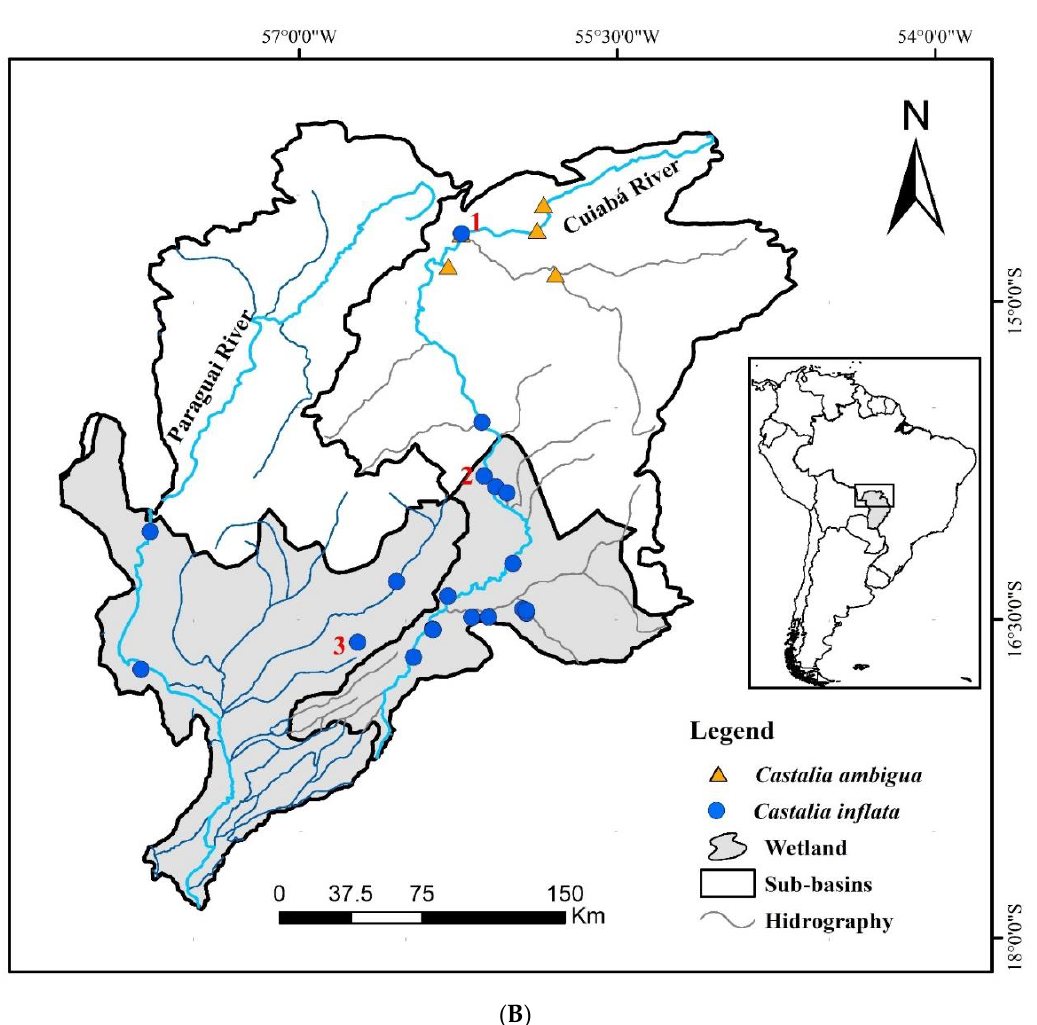
Figure 1. Locations of past and present studies of Castalia species. ( A ) . Chronology of registered occurrences of Castalia ambigua Lamarck, 1819 and Castalia inflata d’Orbigny, 1835 in South America. Orange symbols denote C. ambigua and blue denote C. inflata . The Amazon basin is to the north, and the Paraguay basin to the south. References: Bonetto 1961 [5], Bonetto 1962 [31], Bonetto 1965 [11], Mansur 1970 [7], Serrano et al. 1998 [32], Castillo 2007 [33], Wantzen et al. 2011 [34], Colle and Callil [22], Beasley 2001 [35], Vale et al. 2005 [6], Rumi et al. 2008 [12], Pimpao et al. 2008 [36], and Pimpao and Mansur 2009 [37]. ( B ). Locations of occurrence and sample sites for Castalia ambigua Lamarck, 1819 (orange triangles) and Castalia inflata d’Orbigny, 1835 (blue dots) within the upper Paraguay River basin in this study. Red numerals indicate sample sites for molecular analysis: 1—Baixo Stream (both C. ambigua and C. inflata ); 2—Valo Verde Lake; and 3—Claro River. Lack of shading indicates upland areas; gray shading indicates lowland areas.